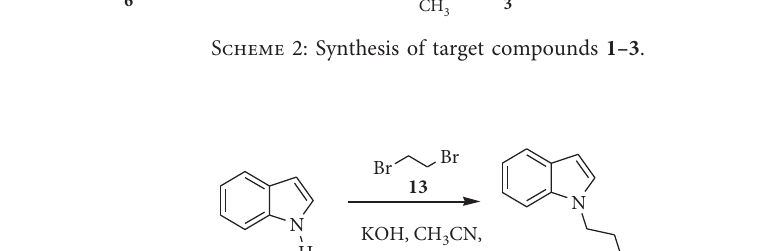
Scheme 2: Synthesis of target compounds 1–3 .